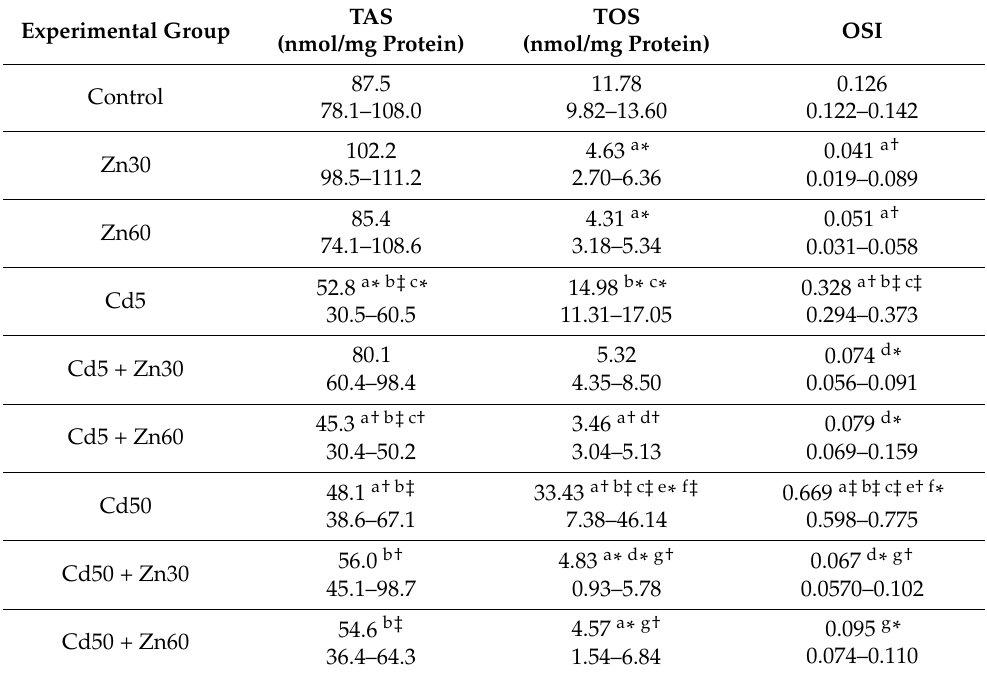
Table 2. TAS, TOS, and OSI in the vascular tissue of the abdominal aorta in particular experimental groups 2 . Experimental